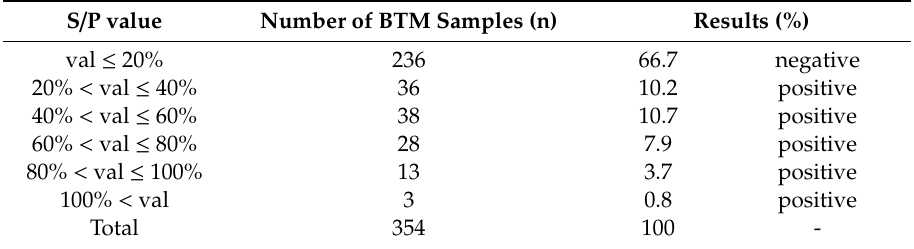
Table 1. Presence of antibodies against the bovine viral diarrhea virus (BVDV) in examined dairy cattle herds, including the number and percentage of positive herds as well as the relative value of specific antibodies (s /